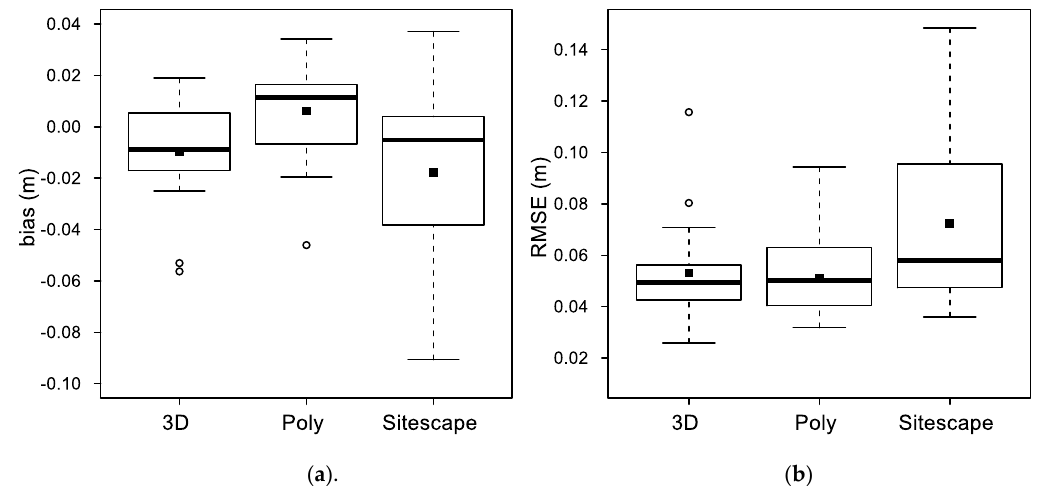
Figure 8. ( a ) Distribution of DTM bias for iPad. ( b ) Distribution of DTM RMSE for iPad. Black squares represent average values over all sample plots.